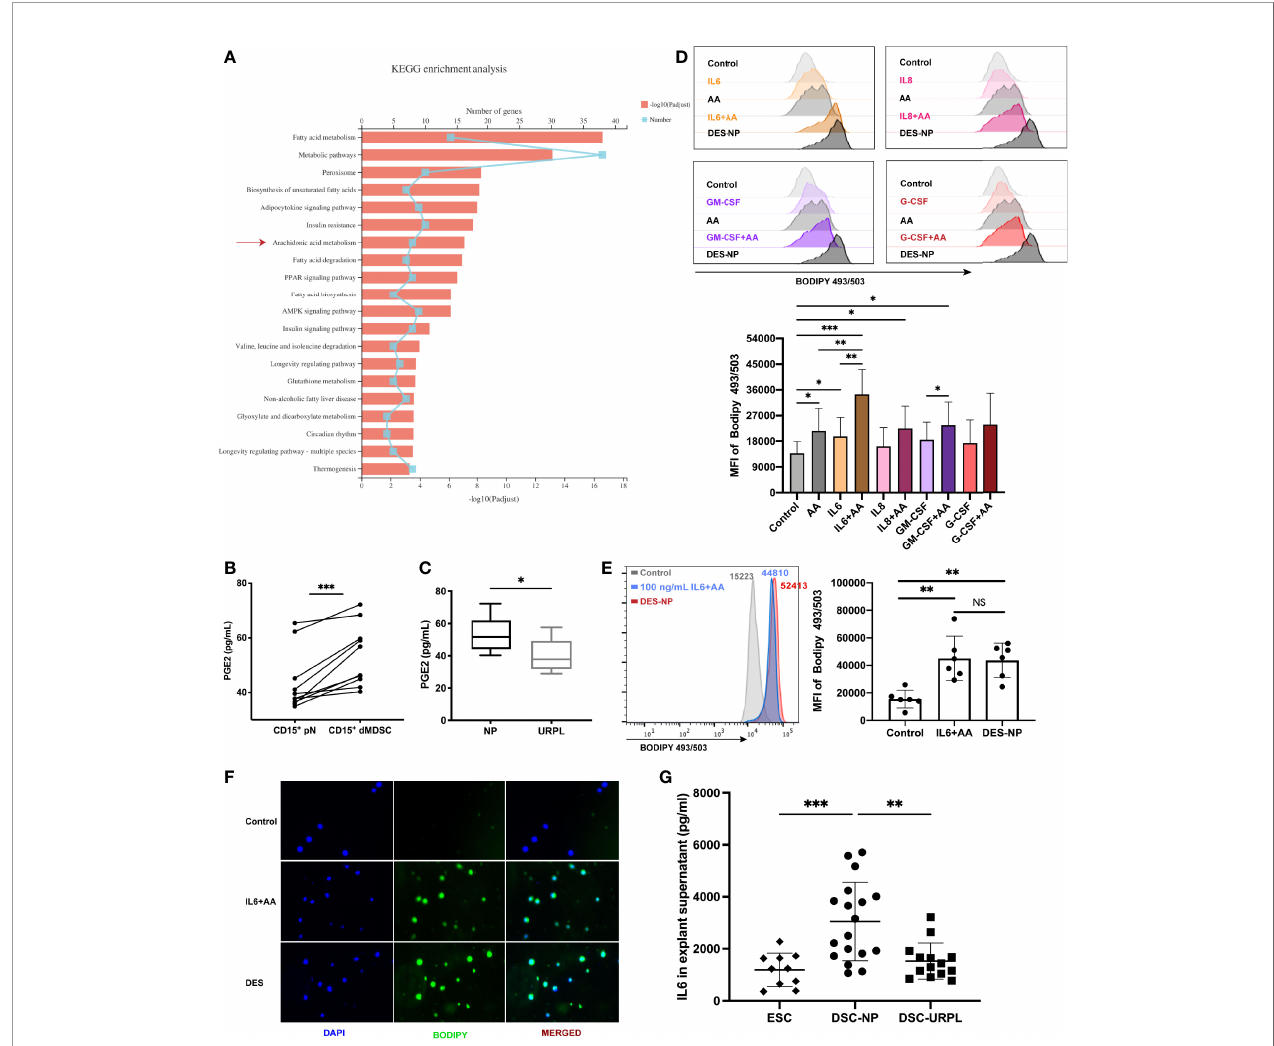
FIGURE 4 | The promotional effect of IL6, a cytokine derived from the decidua, on lipid accumulation supplemented with arachidonic acid (AA). (A) KEGG enrichment analysis of differentially expressed genes in pathways related to fatty acid metabolism. (B) The secretion of PGE2 in CD15+ dMDSCs and autologous pN was detected by ELISA (n = 10). (C) A difference in PGE2 secretion from PMN-MDSCs was found between NP (n = 10) and URPL (n = 5). (D) The effects of different decidual-derived cytokines on lipid accumulation in neutrophils were evaluated by fl ow cytometry, including IL6, IL8, GM-CSF, and G-CSF (n = 5). (E) IL6 promoted the utilization of AA by circulating neutrophils, thus resulting in a similar effect to DES (n = 6). (F) Representative immuno fl uorescence images of BODIPY 493/503 (green) in neutrophils treated with IL6+AA or DES. (G) Differences in IL6 secretion between EES (n = 10), DES-NP (n = 15), and DES-URPL (n = 14). All data are represented as mean ± SD. Signi fi cance was determined by paired or unpaired Student ’ s t-test, or one-way ANOVA with Tukey ’ s post-hoc test. ***p < 0.001, **p < 0.01, *p < 0.05, NS, not signi fi cant. FMO, fl uorescent minus